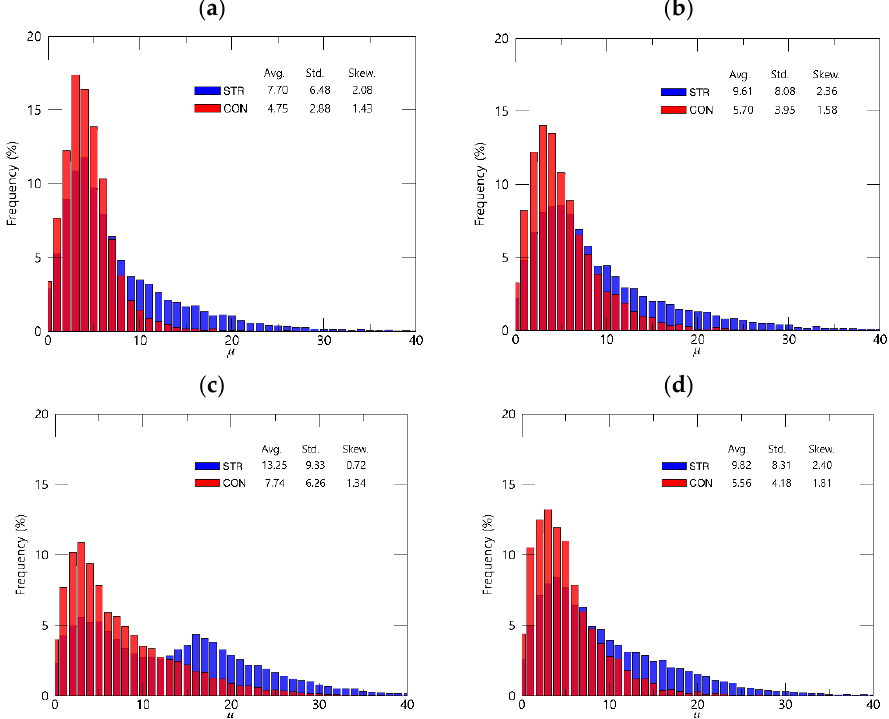
Figure 8. The occurrence frequency of shape parameters with rain type at ( a ) BOS, ( b ) BUS, ( c ) CPO, and ( d ) JIN site. The blue represents stratiform rain and the red represents convective rain. The legend shows the average (Avg.), standard deviation (Std.), and skewness (Skew) of shape param- eter.